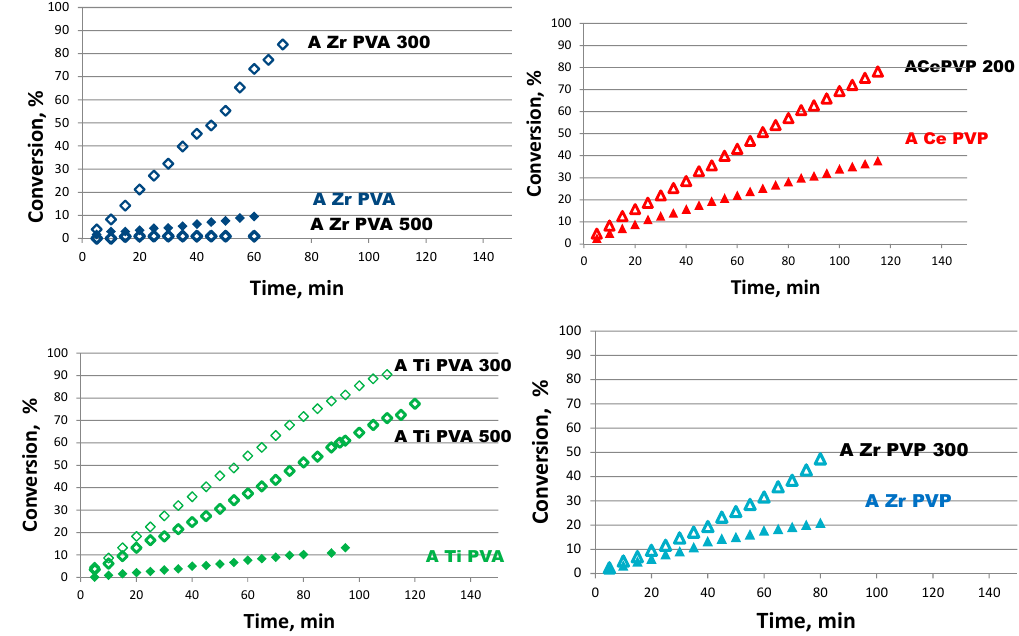
Figure 8. Conversions vs. time of reaction for D ‐ glucose oxidation at 60 °C and 100 cc/min of O 2 for calcined samples.